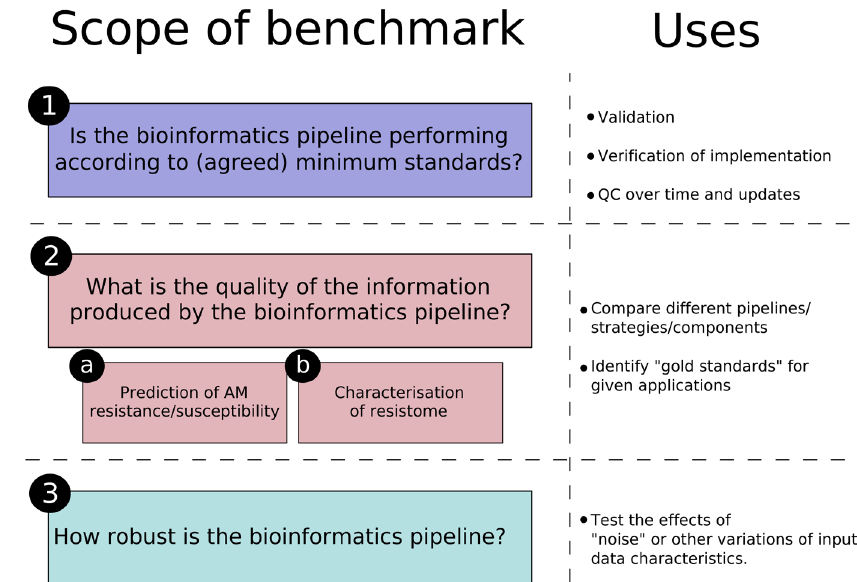
Figure 1. Summary of the different “scopes” for the benchmark resources for AMR detection using next generation sequencing discussed in the current document, with an indication of the uses for